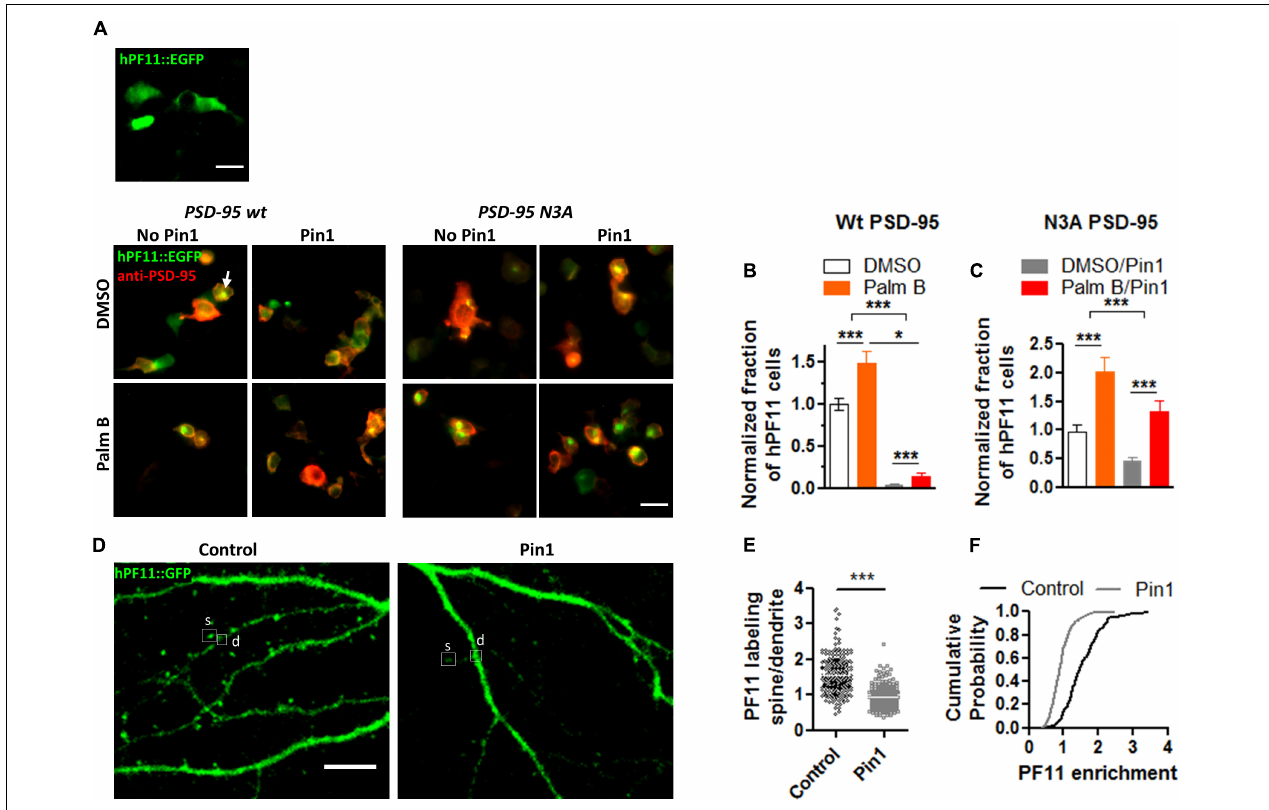
FIGURE 1 | Pin1 reduces the amount of PSD-95 palmitoylation. (A) (top) Wide field images of HEK-293T cells transfected with only hPF11:EGFP. Notice the cytosolic non-punctate distribution. (bottom) DMSO or Palmostatin B-treated HEK 293T cells triple transfected with (1) hPF11:EGFP (green), (2) PSD-95 or the N3A mutant (red), and (3) empty or Pin1 expressing vectors. White arrows point to the intracellular clusters of PSD-95 as in Fukata et al. (2013) and Jeyifous et al. (2016). Scale bar: 10 µ m. (B) Quantification of the effects of Pin1 overexpression on the formation of hPF11 intracellular clusters in DMSO and Palm B pretreatment in PSD-95 wt overexpressing cells. DMSO control 1.00 ± 0.07, n = 20; Palm B control 1.49 ± 0.14, n = 20; DMSO&Pin1 0.04 ± 0.01, n = 20; Palm B&Pin1 0.14 ± 0.05, n = 20. Two-way ANOVA overexpression F (1,76) = 13.43, p = 0.0005, treatment F (1,76) = 203.99, p < 0.0001, interaction F (1,76) = 5.84, p = 0.0181. (C) Quantification of the effects of Pin1 overexpression on the formation of hPF11 intracellular clusters in DMSO and Palm B pretreatment in N3A overexpressing cells. DMSO control 0.96 ± 0.12, n = 20; Palm B control 2.01 ± 0.26, n = 20; DMSO&Pin1 0.45 ± 0.07, n = 20; Palm B&Pin1 1.32 ± 0.19, n = 20. Two-way ANOVA overexpression F (1,76) = 30.78, p < 0.0001, treatment F (1,76) = 11.82, p = 0.0010, and the interaction F (1,76) = 0.28, p = 0.6015. (D) Confocal images of hippocampal cultured neurons at 18 days in vitro (DIV) expressing hPF11 in control and Pin1 overexpressing cells. The C113S isomerase mutant was used instead. Similar results were observed between the wt Pin1 and C113S. Scale bar: 10 µ m. (E) Quantification of the enrichment ratio for hPF11 in control and Pin1 overexpressing neurons. Control 1.54 ± 0.04, 46 neurons, n = 213 spines; Pin1 0.93 ± 0.02, 49 neurons, n = 233 spines, Mann–Whitney test p < 0.0001. (F) Cumulative probability plot showing a reduction in the enrichment of hPF11. * p < 0.05 and *** p <